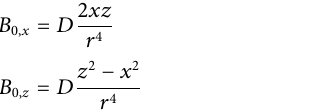
FIGURE 1 Schematic of the simulation